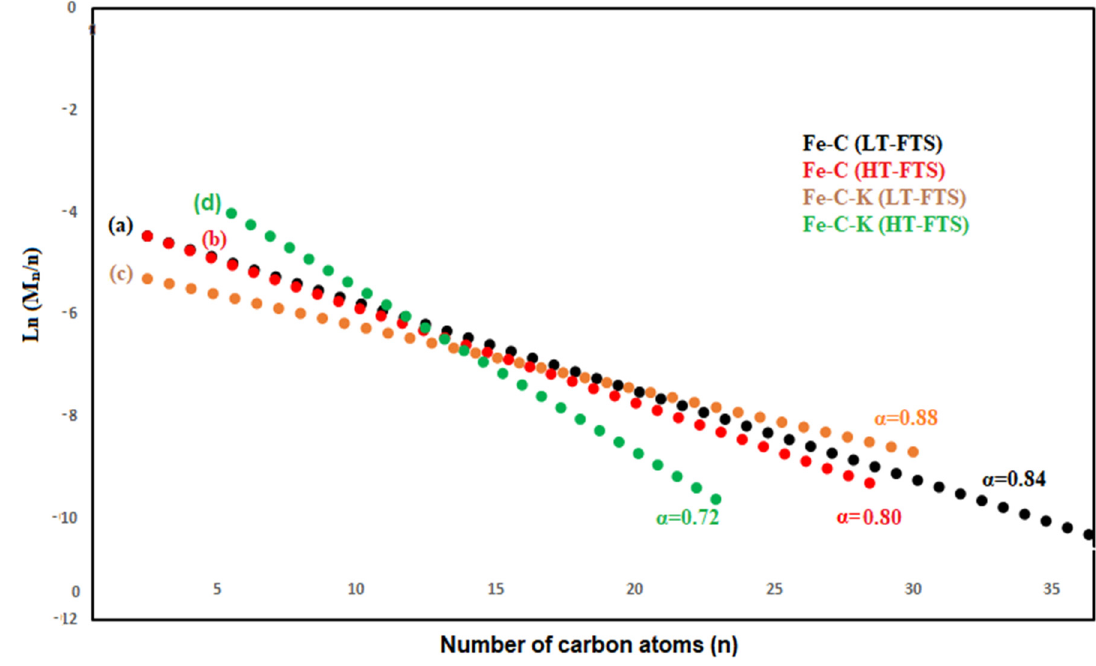
Figure 8. Product composition: (a) Fe-C (LT-FTS), (b) Fe-C (HT-FTS), (c) Fe-C-K (LT-FTS), and (d) Fe-C-K (HT-FTS).